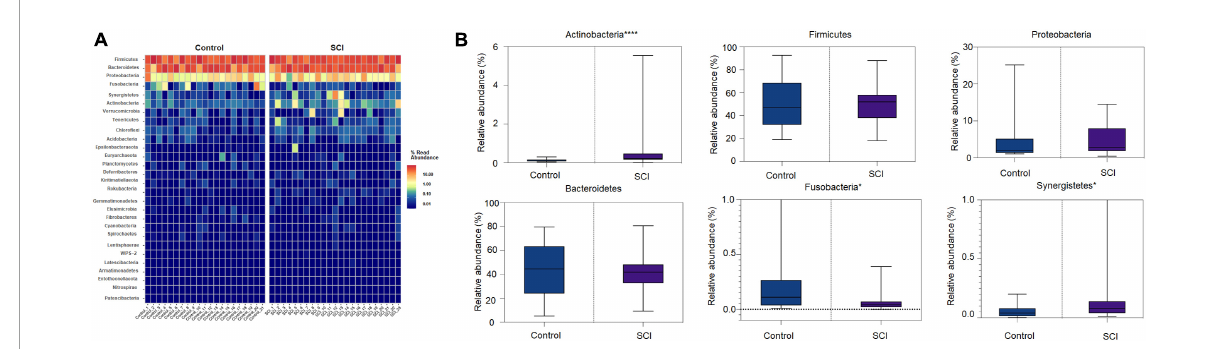
FIGURE3 Analysis of the composition of the gut microbiota at the phylum level. (A) Heat map of the gut microbiota at the phylum level. (B) The relative abundance of dominant microbiota at the phylum level. Each boxplot represents the median, quartile range, minimum and maximum values. Each dot represents a subject. The data was expressed as median (interquartile range); * P < 0.05, **** P < 0.0001.